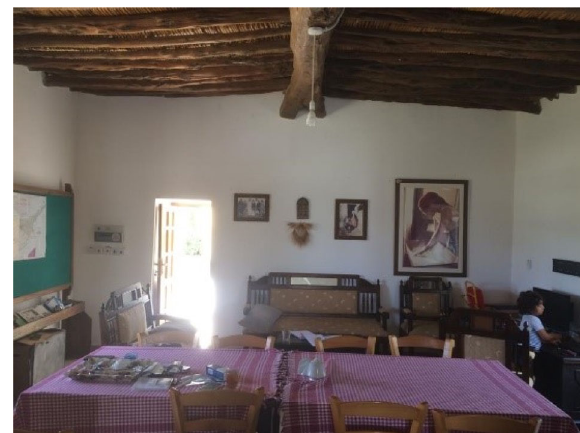
Fig. 21 Galifes Guest House. Example of a wooden rafter ceiling —